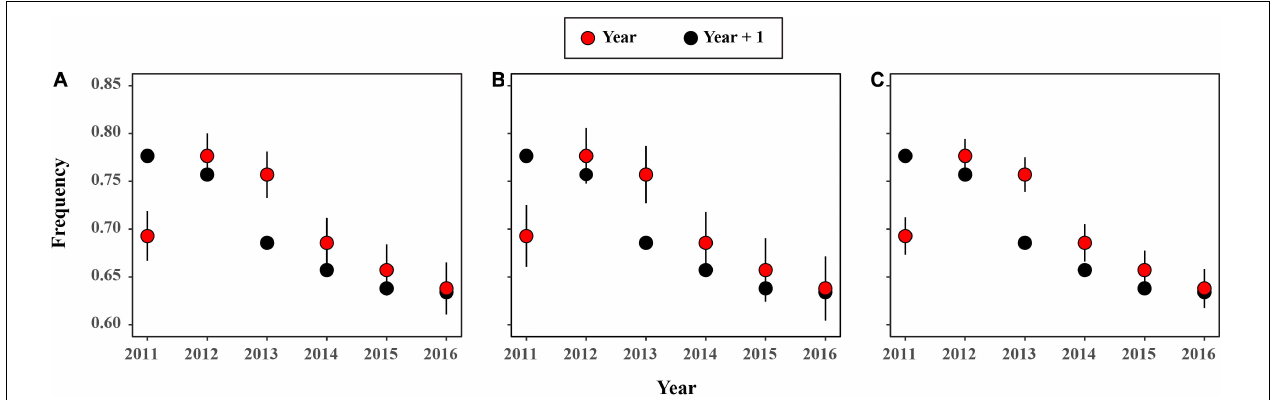
FIGURE 3 | Expected changes in frequency for the color polymorphism, assuming genetic drift. Red dots represent the allele frequency observed in the year at the x axis while black dots represent the observed frequency of alleles the following year (e.g., the black dot on 2011 corresponds to the frequency in 2012). The bars indicate the 95% confidence interval of the expected frequencies under genetic drift, using the estimated effective population size ( N e ) on equation 1 (see section “Materials and Methods”). Thus, black dots outside confidence intervals indicate that the change in frequency from 1 year to the next cannot be explained by genetic drift. Plots indicate results for N e = 600 (A) , 394 (B) , and 1076 (C)